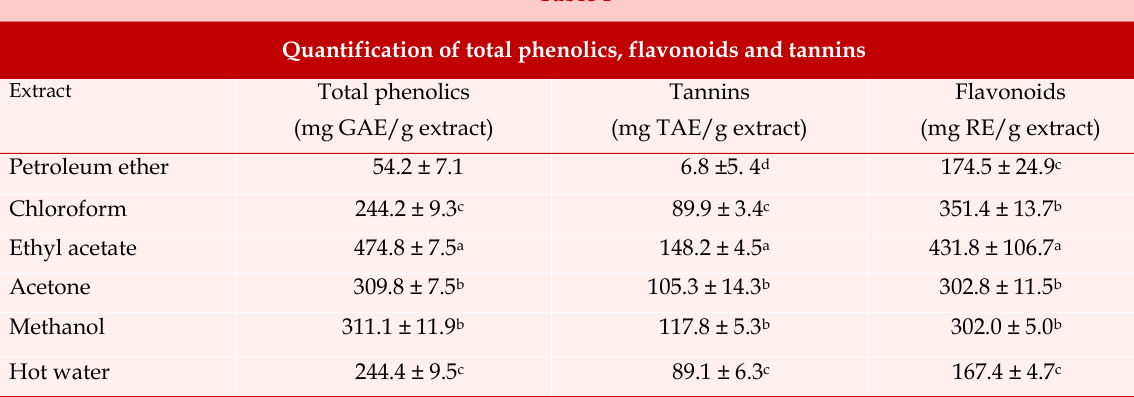
Quantification of total phenolics, flavonoids and